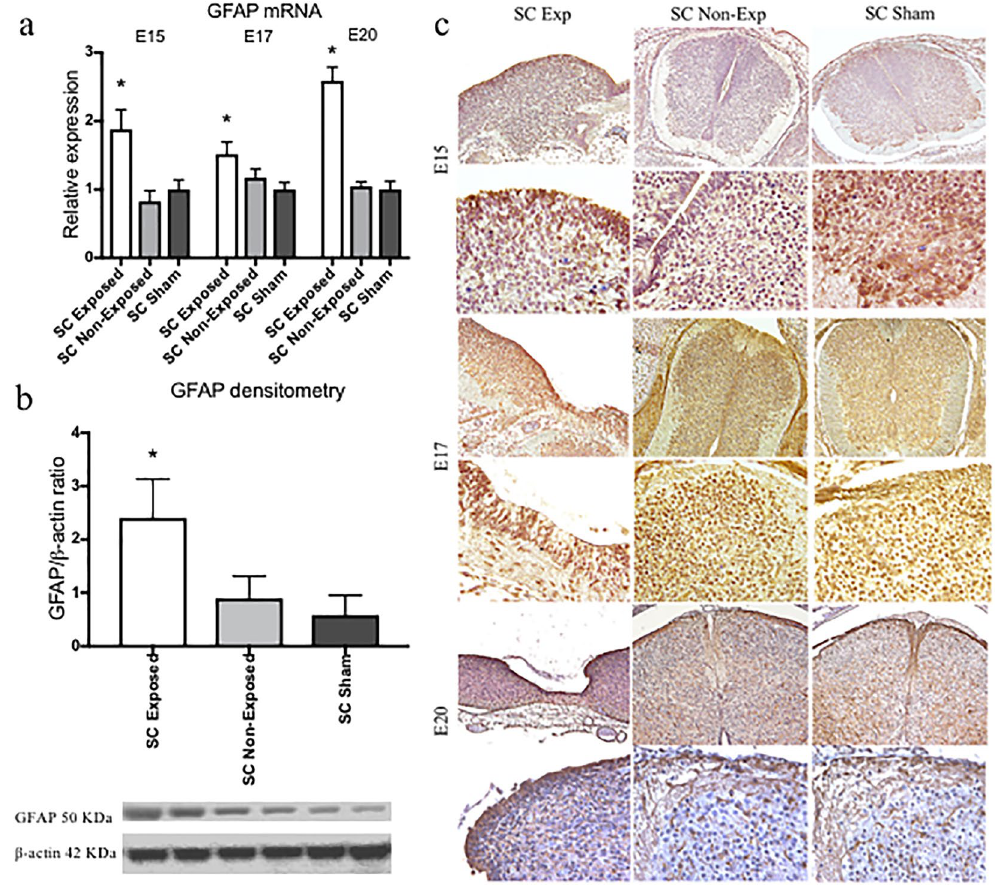
Figure 3. Immunohistochemistry staining and quantification of GFAP expression. ( a ) GFAP relative expression increased in spina bifida in exposed neural tissue compared with unexposed spina bifida and sham animals. Values (means ± SE, 6 fetuses/group) of relative expression (2 −ΔΔ Ct ) for RA-treated and time-matched controls ( * p < 0.05). ( b ) Western blot confirmed GFAP protein levels were higher in exposed spinal cords in spina bifida than unexposed or sham cords ( * p < 0.05). Densitometry ratio (mean ± SD, 6 fetuses/group) and representative cropped bands from the same gel GFAP (50KDa) and β -actin (42 KDa). ( c ) GFAP-immunoreactive astrocytes in the spinal cord sections of spina bifida exposed, unexposed, and sham fetuses at E15, E17, and E20 (10 × and 40 ×